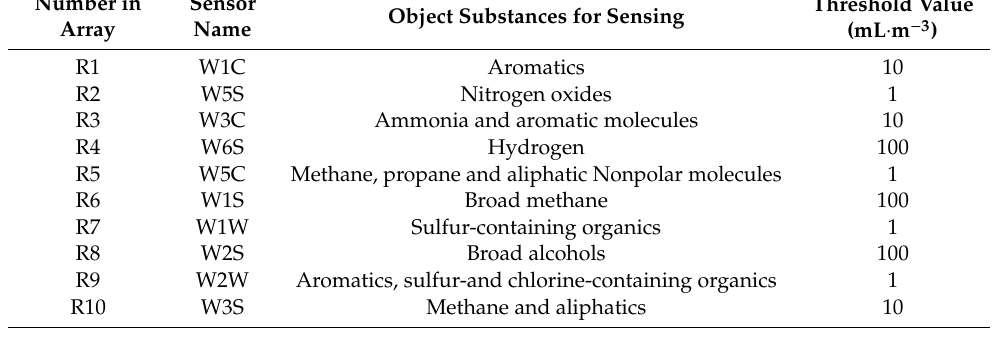
Table 3. The response features of the sensor array.